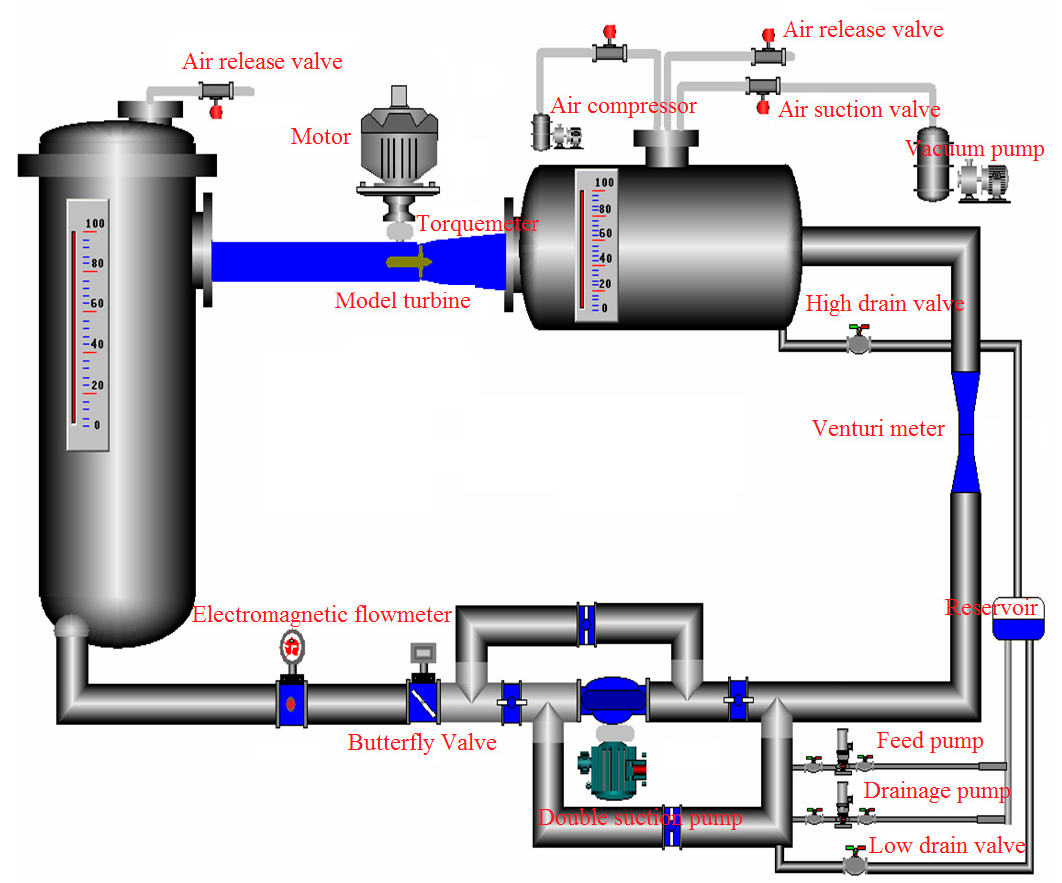
Figure 6. The standard test rig.